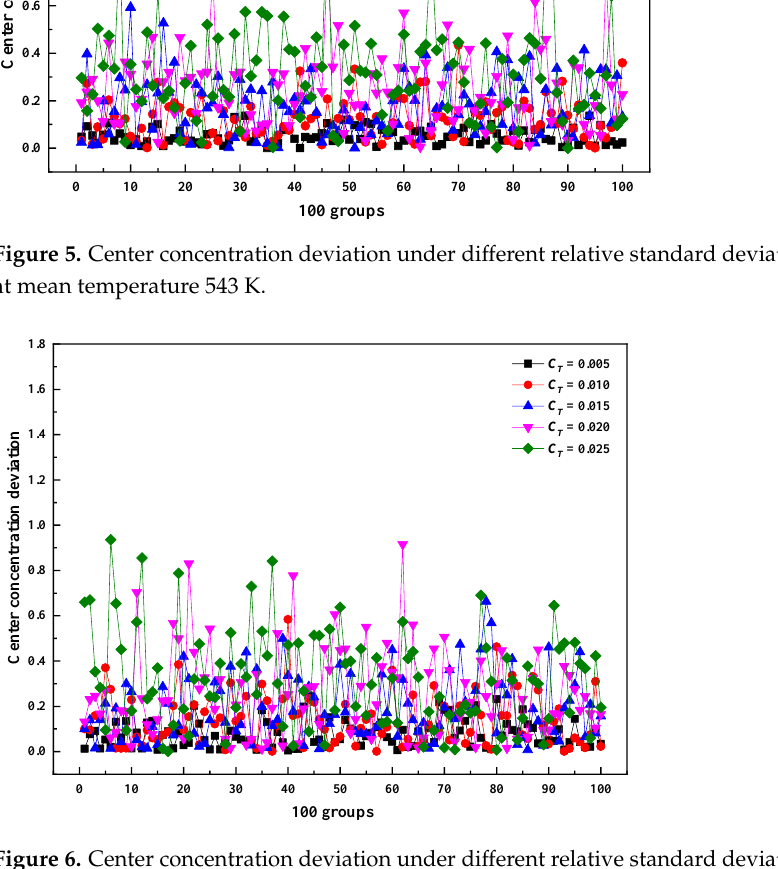
Figure 7. Center concentration deviation under different relative standard deviations of tempera- ture at mean temperature 563 K. Figure 8. Relationship between different relative standard deviations of temperature and the mean of center concentration deviation.